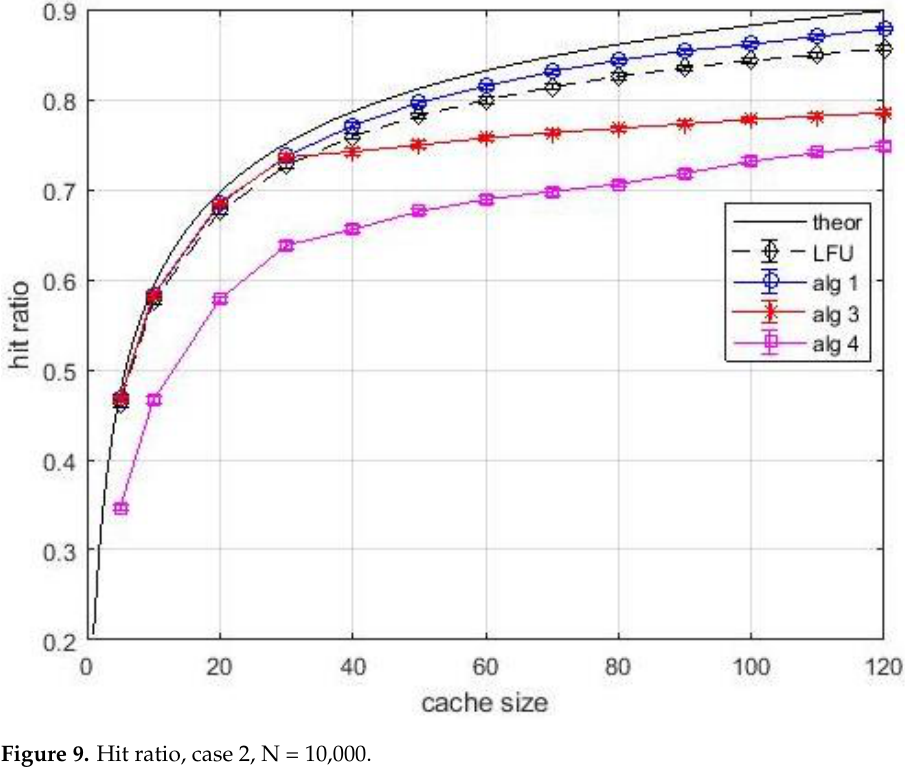
Figure 9. Hit ratio, case 2, N = 10,000.